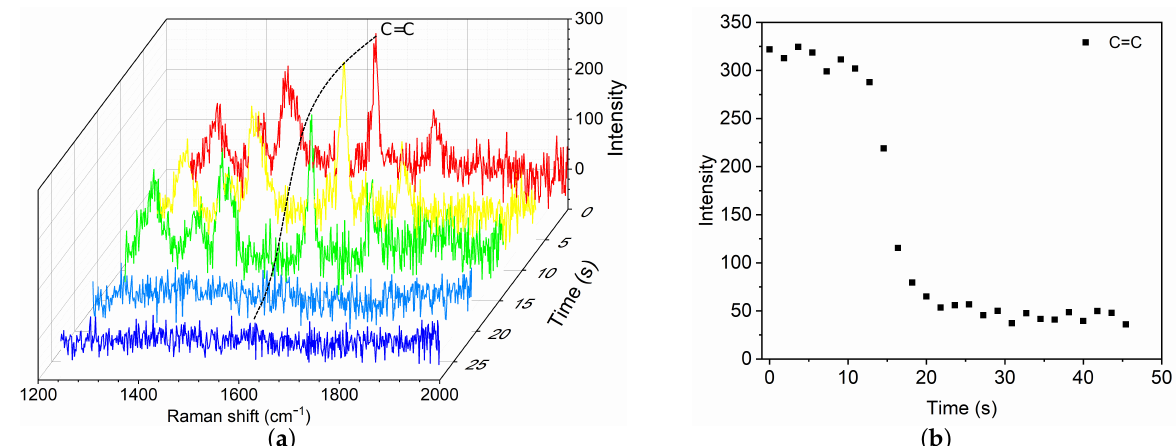
Figure 3. Time evolution of Raman spectra ( a ) and C = C intensity change at 1617 cm − 1 ( b ) during the fast polymerization phase of GO mixture ( C G = 50%) in contact with blood substitute BSA8.